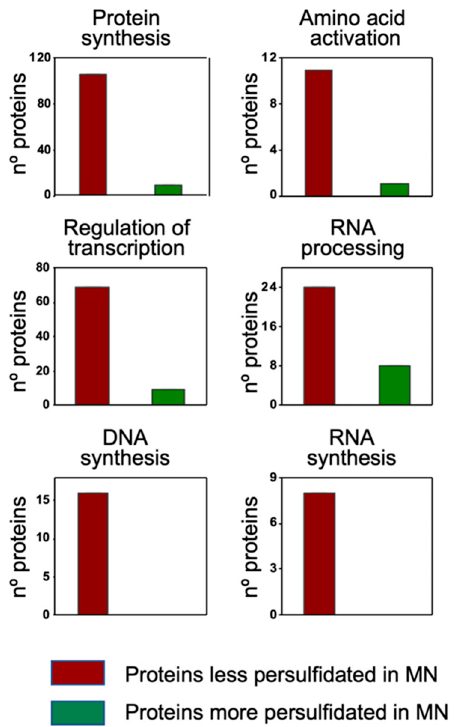
Figure 6. MapMan classification by Cell Function of the differentially persulfidated proteins in N-starvation (MN) medium compared to N-sufficient medium (PN). Adapted from the Cell_function overview_mapping image.